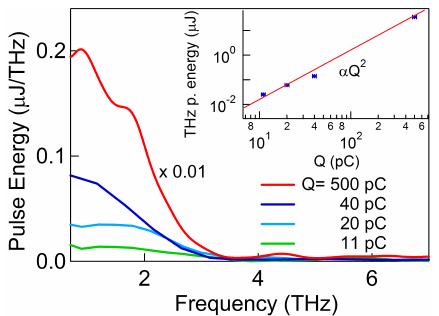
Figure 4. Low charge regime: Spectral distribution intensity measured by Michelson interferometer for different bunch charge Q. Inset: generated THz energy per pulse as a function of bunch charge Q. The curve for the highest bunch charge (500 pC) has been scaled by a factor of 100. Experimental data (blue dots), Q 2 dependence (red line). The integrated THz intensities per pulse shown in the inset are affected by a systematic uncertainty due to the missing calibration of the THz-I-BNC GENTEC-EO pyroelectric detector at low frequencies (below 0.6